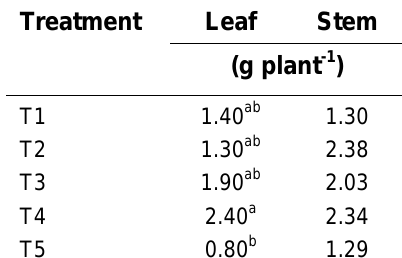
Urea-N Uptake in Leaf and Stem of Swan at 90 DAP